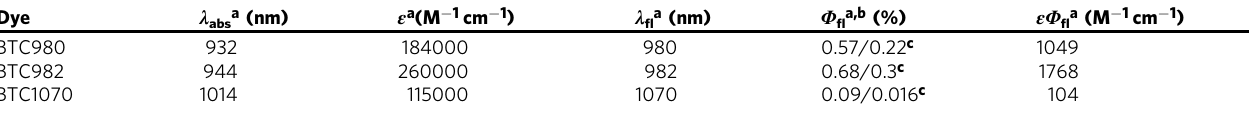
Table 1 Photophysical properties of